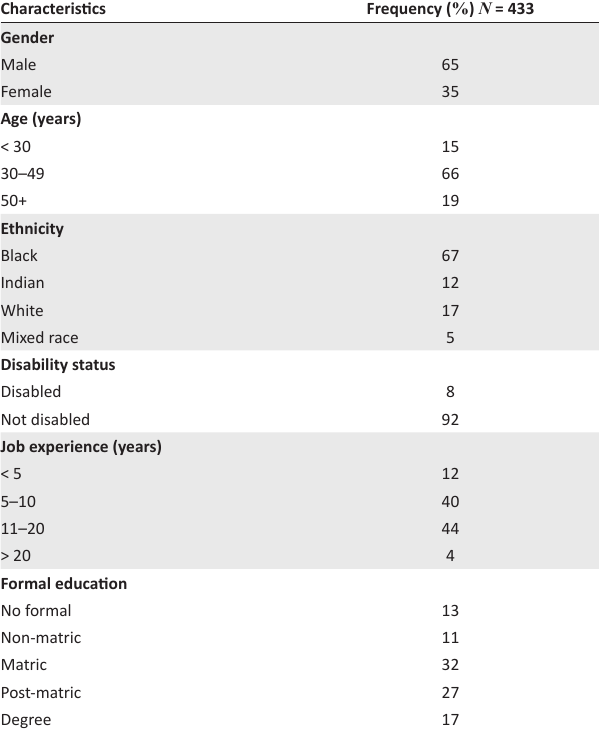
TABLE 3: Reliability and validity